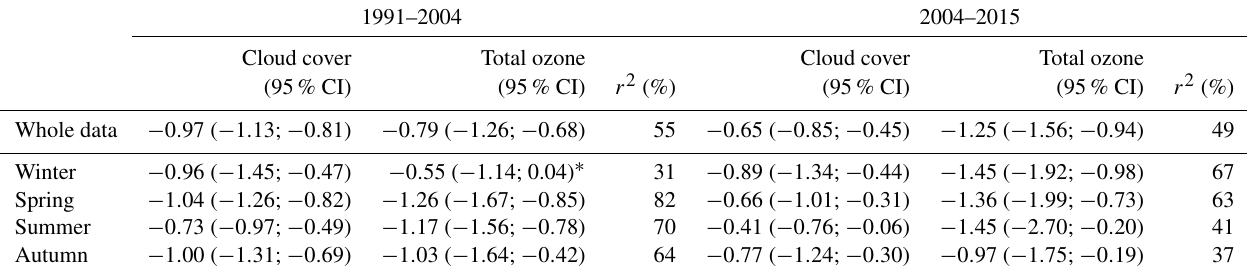
Table 7. Estimated effect on H er with 95% CI from the combined effect of TO and CC trend for two sub-periods: 1991–2004 and